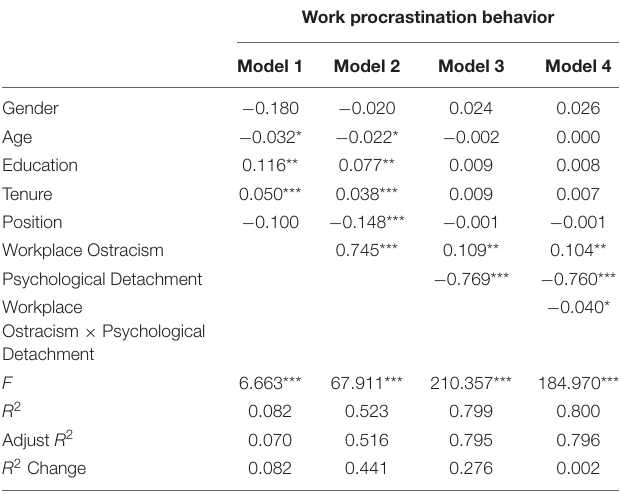
TABLE 4 | Moderating effect of psychological